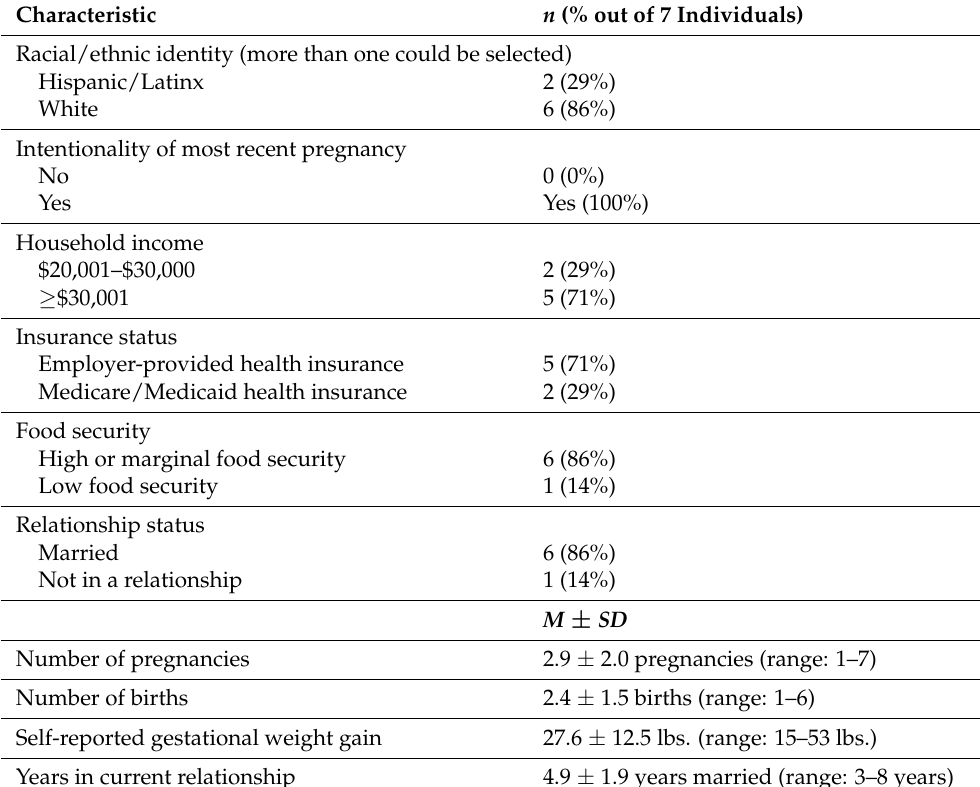
Table 1. Stakeholder interview participant characteristics ( n =